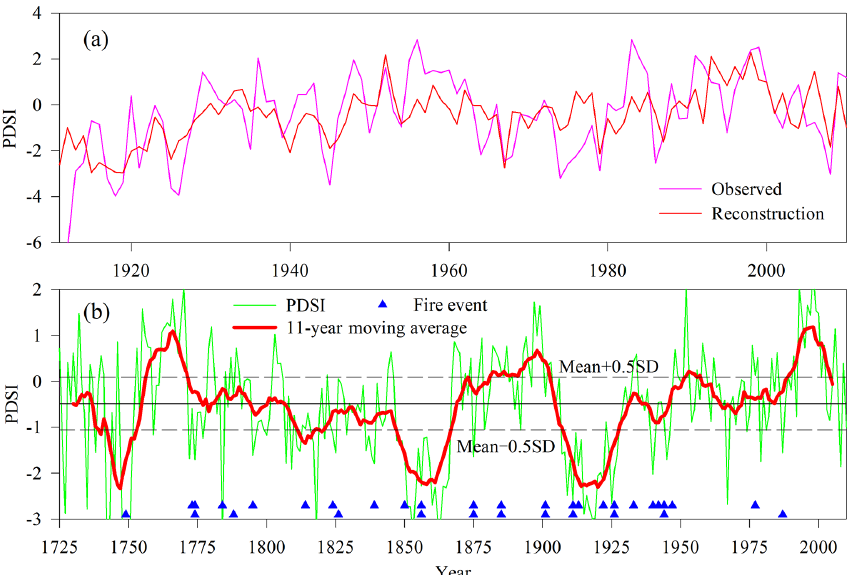
Figure 4. The reconstruction PDSI series in the Daxing’an Mountains, northeast China. (a) Comparison of the observed (pink line) and reconstructed (red line) annual PDSI during the calibration period (1911–2010). (b) The reconstruction series of annual PDSI, plotted annually from 1725 to 2010 (green line), along with a smoothed 11-year moving average (red bold line); blue-filled triangles indicate a forest fire in nearby area reconstructed from tree-ring fire scars in Mengkeshan (higher) and Pangu (lower), northern Daxing’an